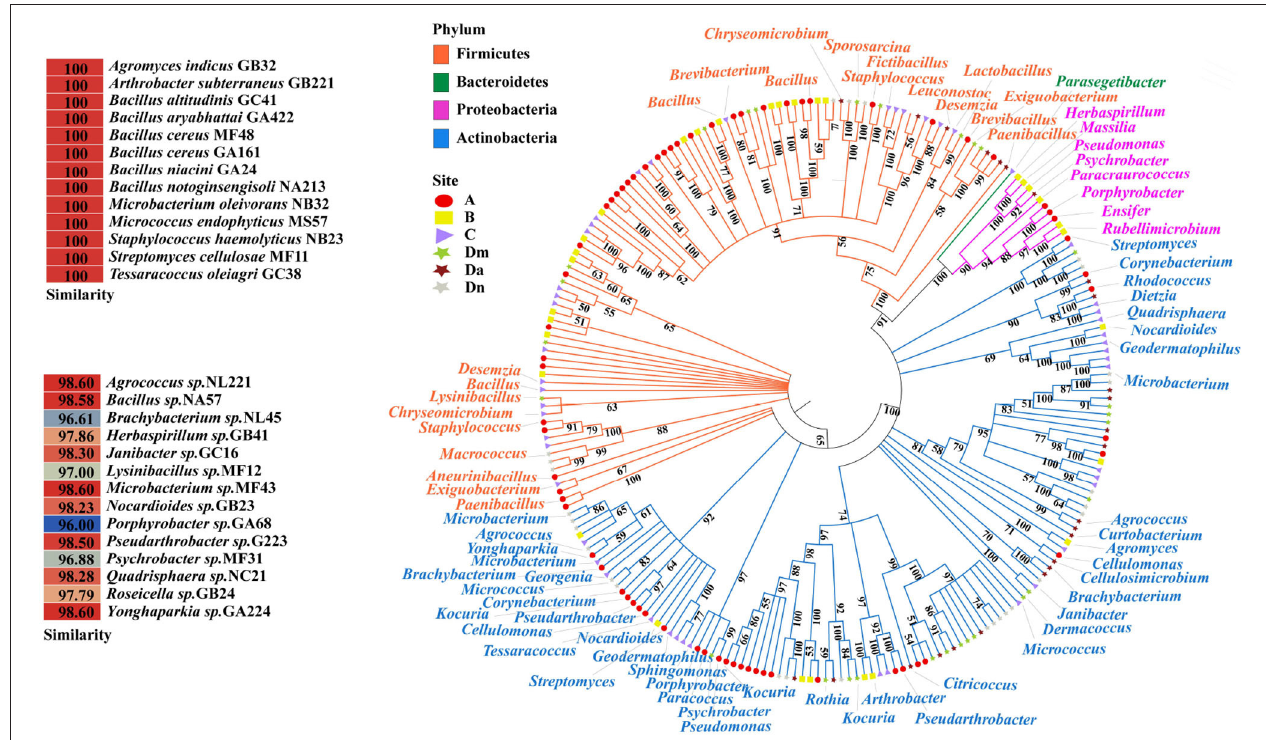
FIGURE 1 | The phylogenetic tree of culturable bacteria from six airborne samples. The red circle indicates the residential area (A) ; the yellow square indicates the e-industrial park (B) ; the purple triangle indicates the office area (C) ; and the stars represent the waste transfer station (D) , when morning in green (Dm) , afternoon in brown (Da) , and night in gray (Dn) . The 16S rRNA sequences of all bacteria isolated from ambient air were aligned using the ClustalW program. The neighbor-joining tree was constructed using MEGA7.0. All branches have a bootstrapping value of at least 50% based on 500 bootstrap replicates. The pop-out table shows isolates with similarities of 100 or < 98.7%.